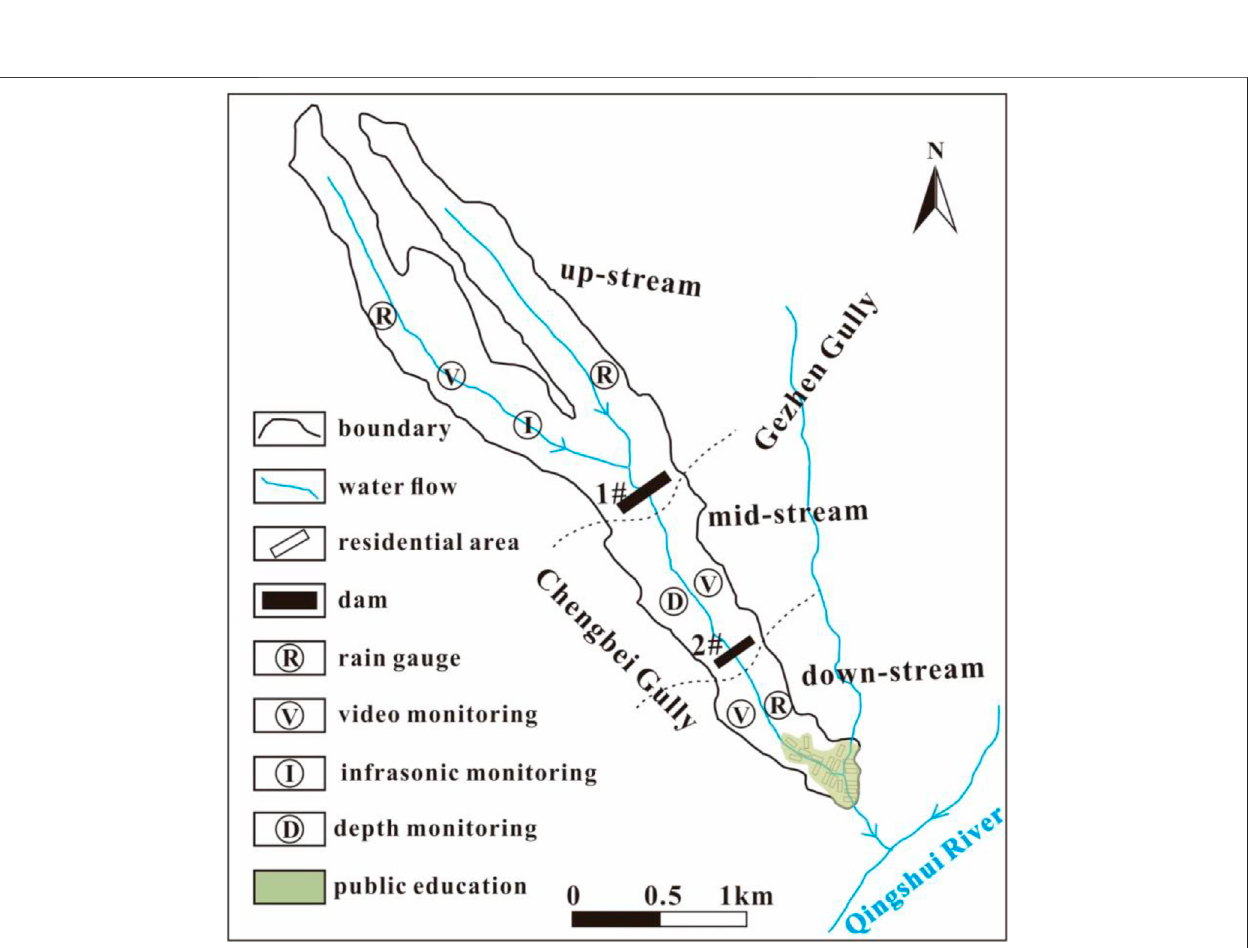
FIGURE 9 | Implementation of potential risk mitigation measures for the Chengbei debris fl ow.